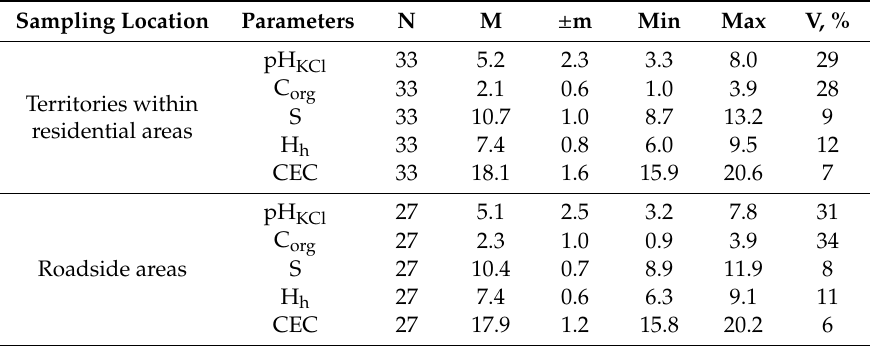
Table 3. Statistical parameters of the physical and chemical properties of the upper soil horizons (0–10 cm) of the residential zone of Gubakha ( p = 0.05).